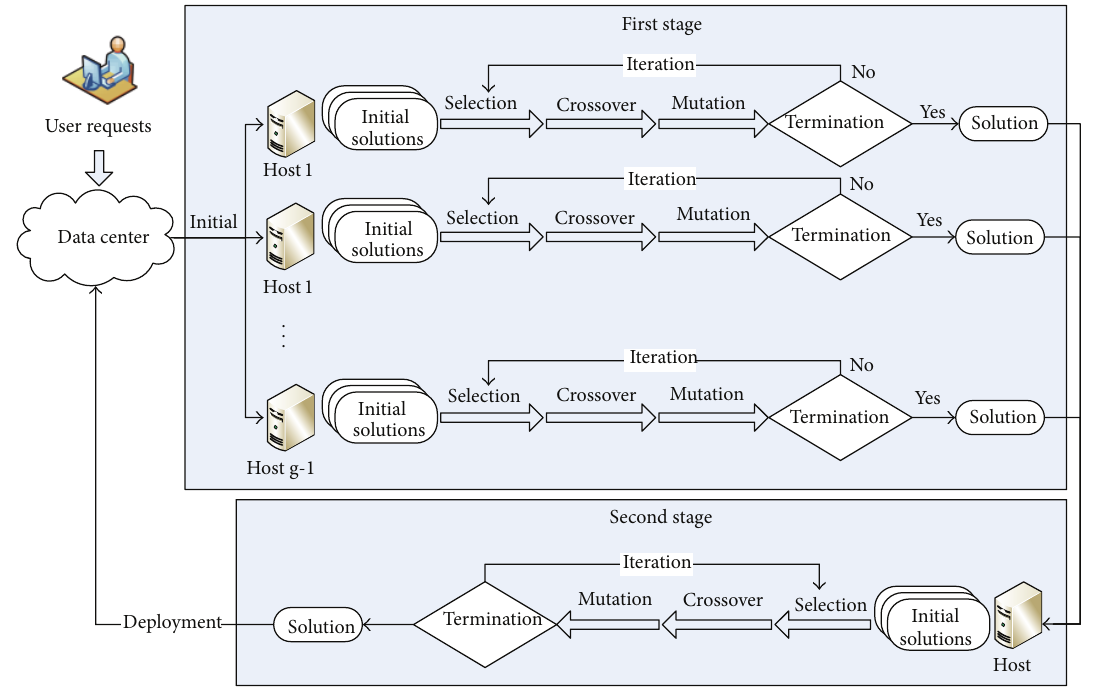
Figure 1: Distributed parallel genetic algorithm of VMs